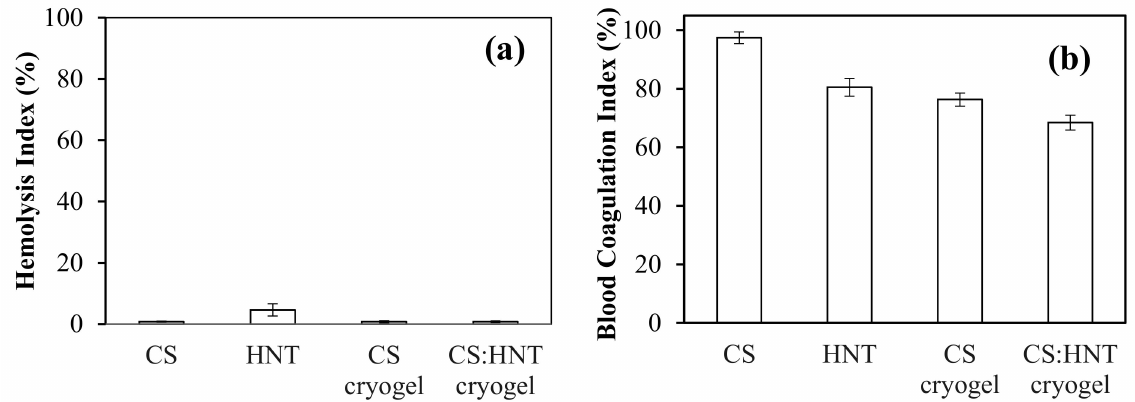
Figure 5. Hemocompatibility test of CS, HNT, CS cryogel and CS:HNT cryogels, ( a ) hemolysis test and ( b ) blood coagulation